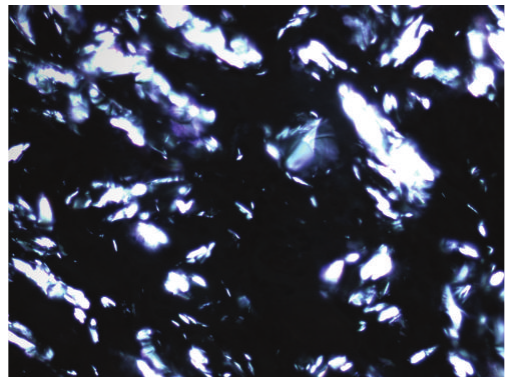
Figure 5: High-power view (H&E, × 400) of polarized light microscopy of Figure 3, showing the birefringent characteristics of the